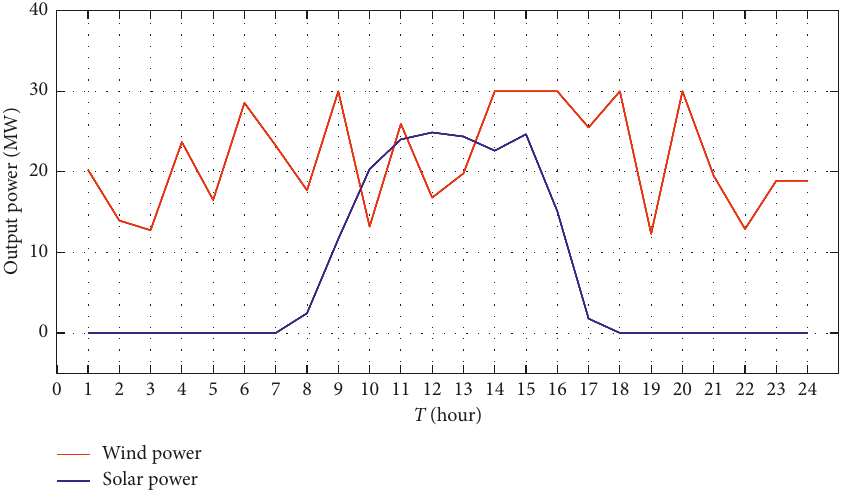
Figure 4: Predictive wind power and solar power for the 24 hours, next day t .